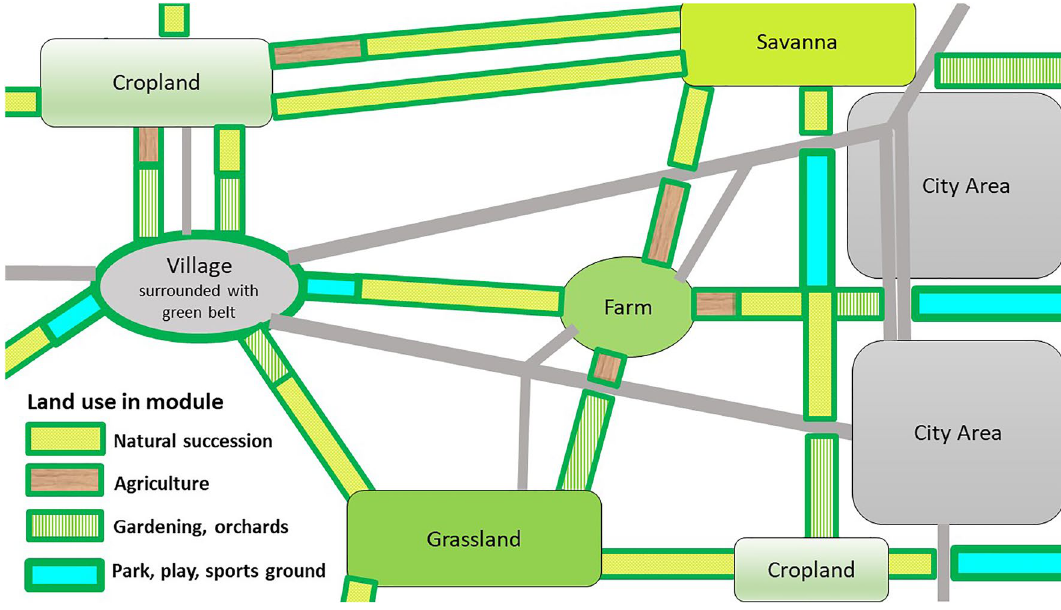
Fig. 2 Vegetation network and value creation for local communi- ties. Twin belt modules close to city with sections for recreation or gardening, and modules in rural areas with sections of agriculture.